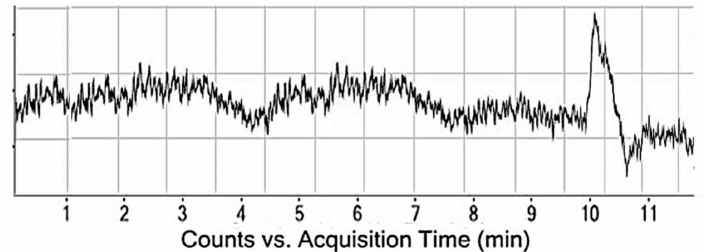
Figure 5. LOD chromatogram for the malachite green